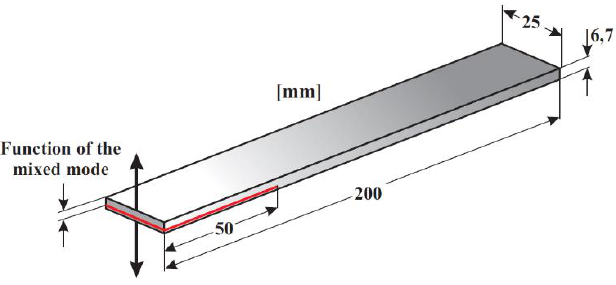
Figure 1. Geometry of the specimen.